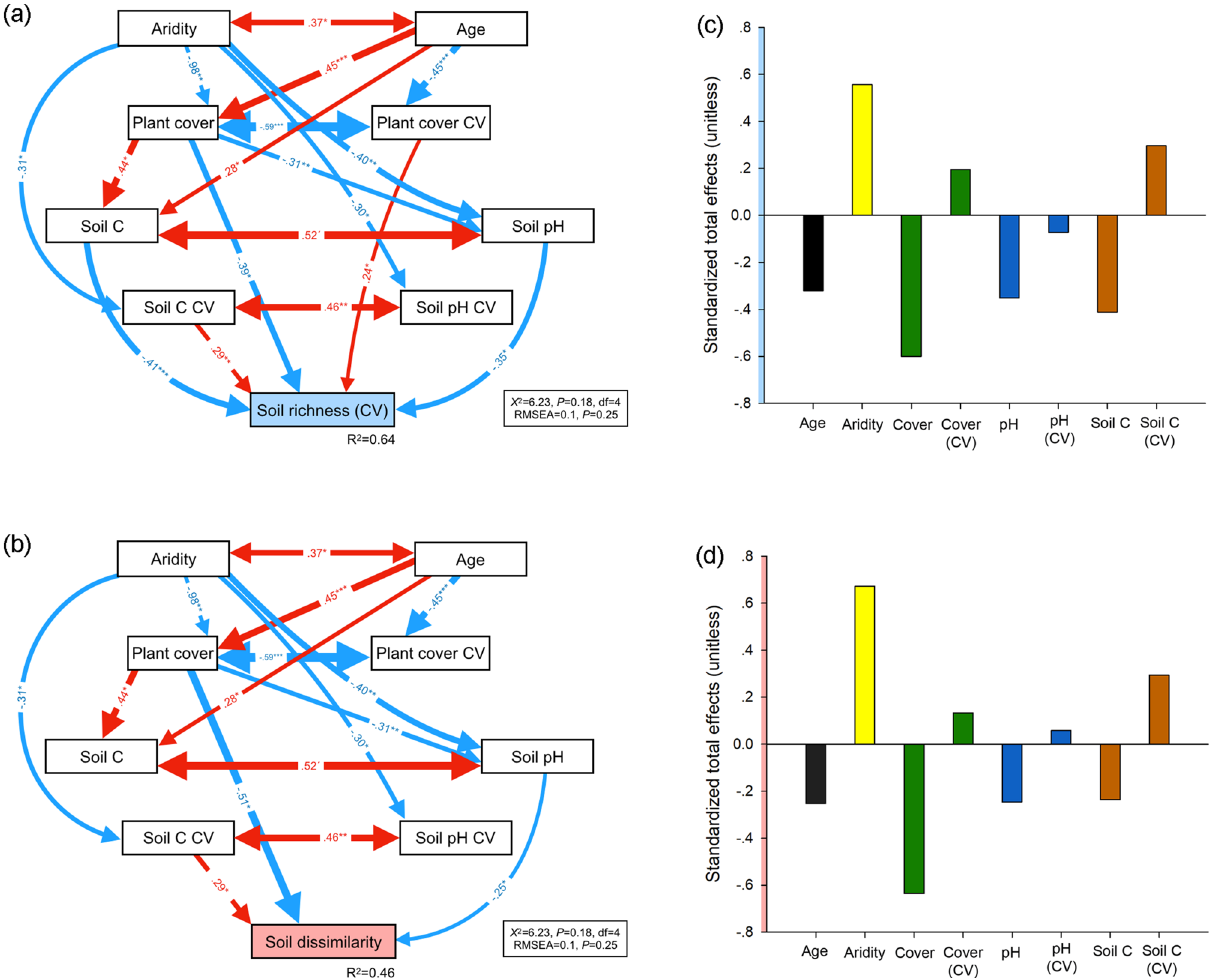
Figure 3. Structural equation models describing the effects of aridity, age, and plant and soil attributes on the belowground spatial variability of soil richness ( a ) and community composition dissimilarity ( b ). Numbers adjacent to arrows are standardized path coefficients, analogous to relative regression weights, and indicative of the effect size of the relationship. *P < 0.05, **P < 0.01, ***P < 0.001. Only significant relationships (P < 0.05) are shown. Red and blue arrows indicate positive and negative relationships, respectively. Arrow widths are proportional to the strength of the relationship. The proportion of variance explained (R 2 ) appears alongside the response variable in the model. Goodness-of-fit statistics for each model are shown in the bottom ( df degrees of freedom, RMSEA root mean squared error of approximation). Panels ( c , d ) show the standardized total effects (direct plus indirect effects derived from the structural equation models) of the different explanatory variables on the spatial variability of belowground richness and community composition dissimilarity,